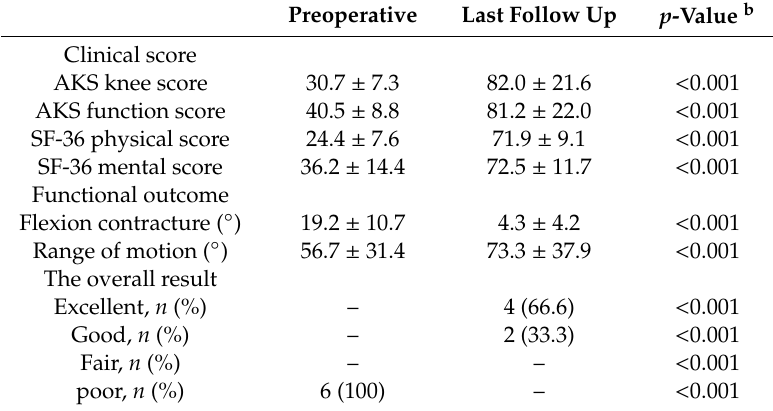
Table 5. Clinical outcomes between the preoperative and the latest follow up in patients with inhibitors a .